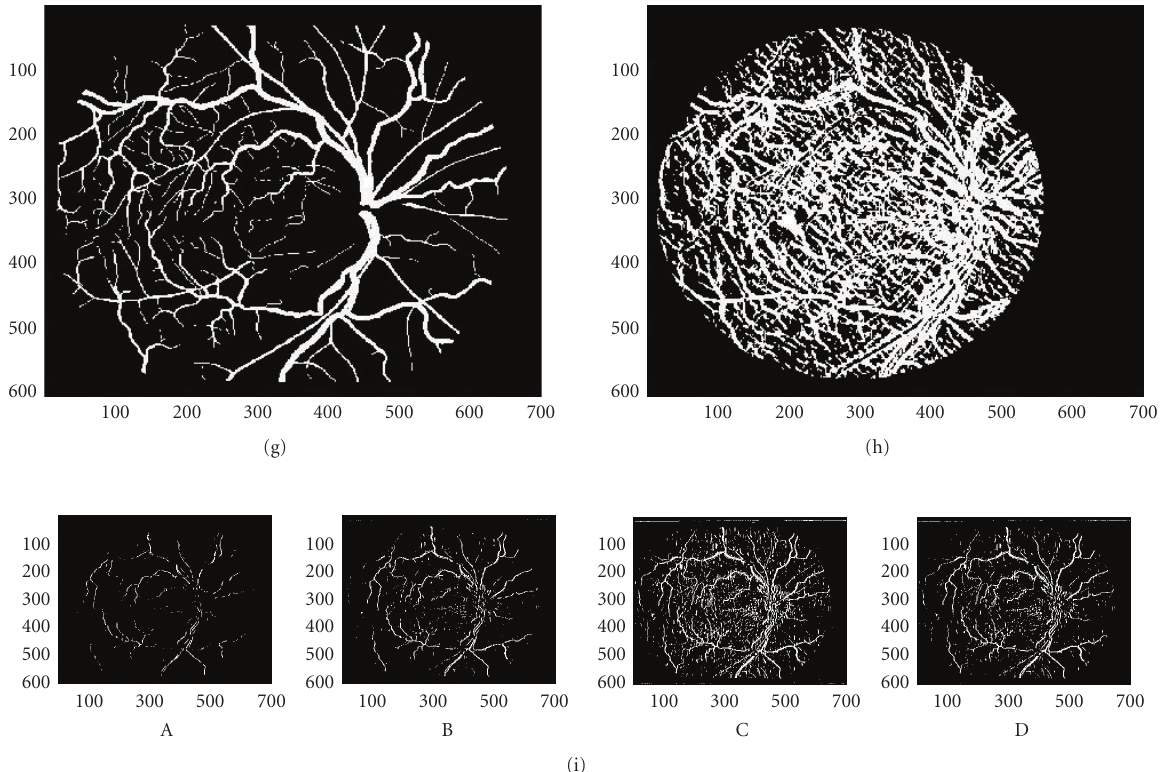
Figure 1: (a) Original fundus image with not well-traced peripheral network. (b) Original fundus image ellipse corrected. (c) Binary vessel wall pixel map (VWP). (d) Vessel map based on VWP. (e) Retinal Vasculature based on VWP and fine segmented for local details. (f) Retinal Vasculature without VWP map using MIP. (g) Ground troth vessel vasculature. (h) Redundant vessel vasculature produced using an Augmented VM and double-sided GS-MG. (i) Successive maps taken using di ff erent features and di ff erent sensitivity. (A) Gradient homogeneity VMs. (B) Paired VP map and dominant gradient VM. (C) Increased vessel width allowed, lower gradient threshold and interpolated WPs. (D) Experimentally proved